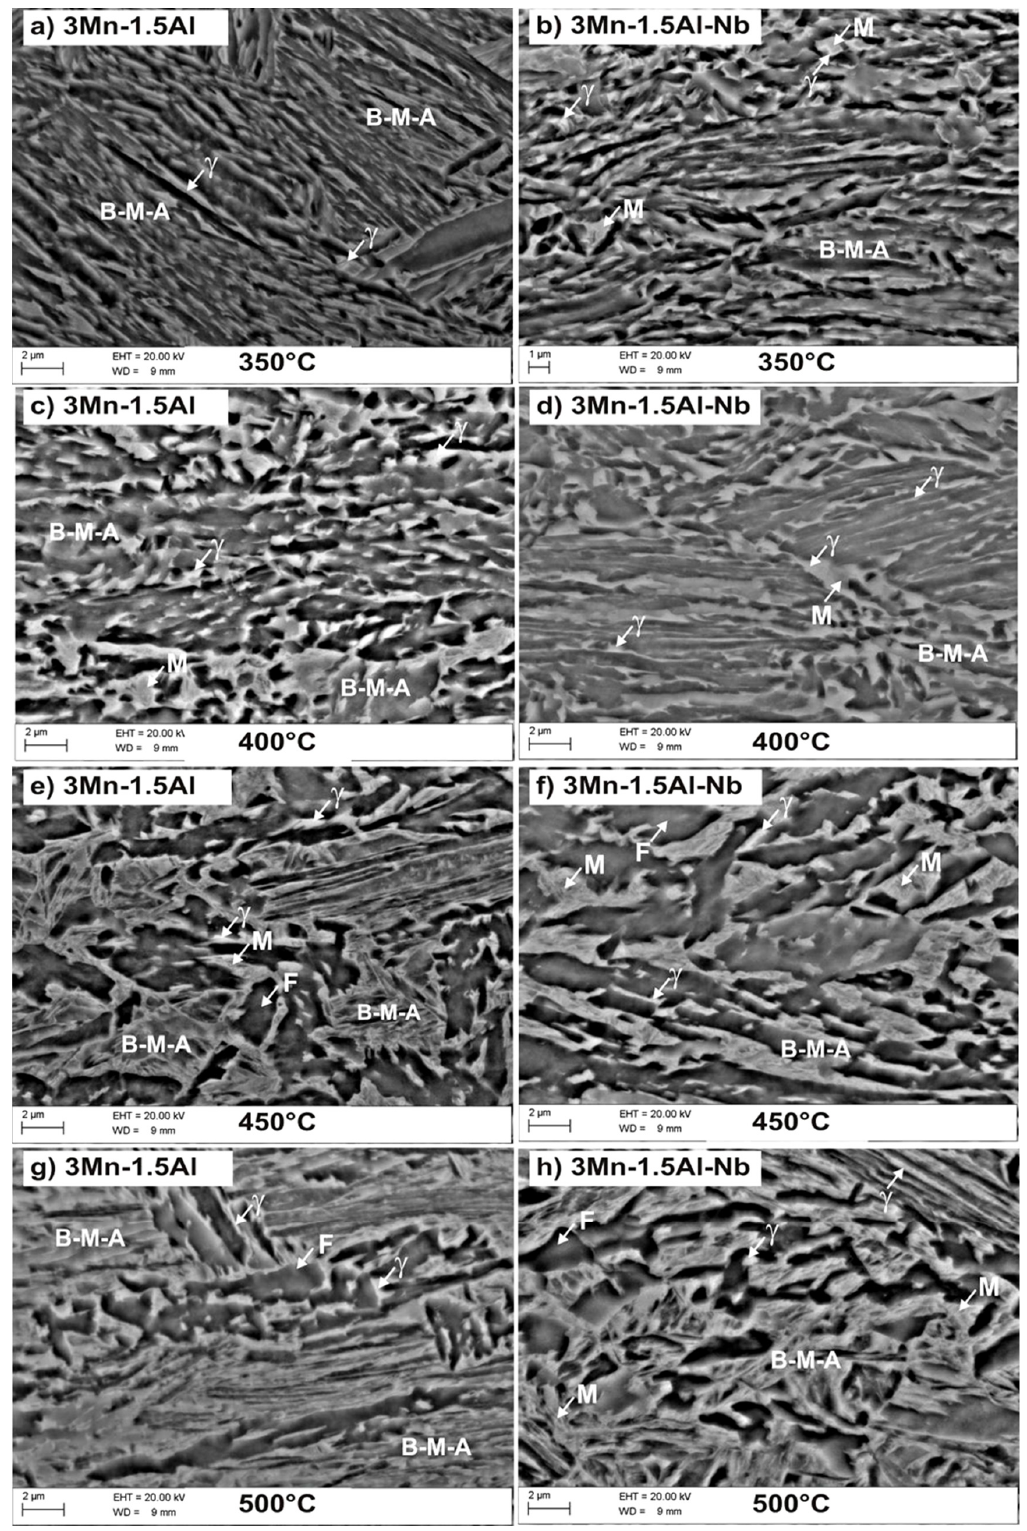
Figure 8. Multiphase microstructure of 3Mn and 3MnNb steels isothermally held at: ( a ) and ( b ) 350 °C, ( c ) and ( d ) 400 °C, ( e ) and ( f ) 450 °C, ( g ) and ( h ) 500 °C, for 300 s (SEM).